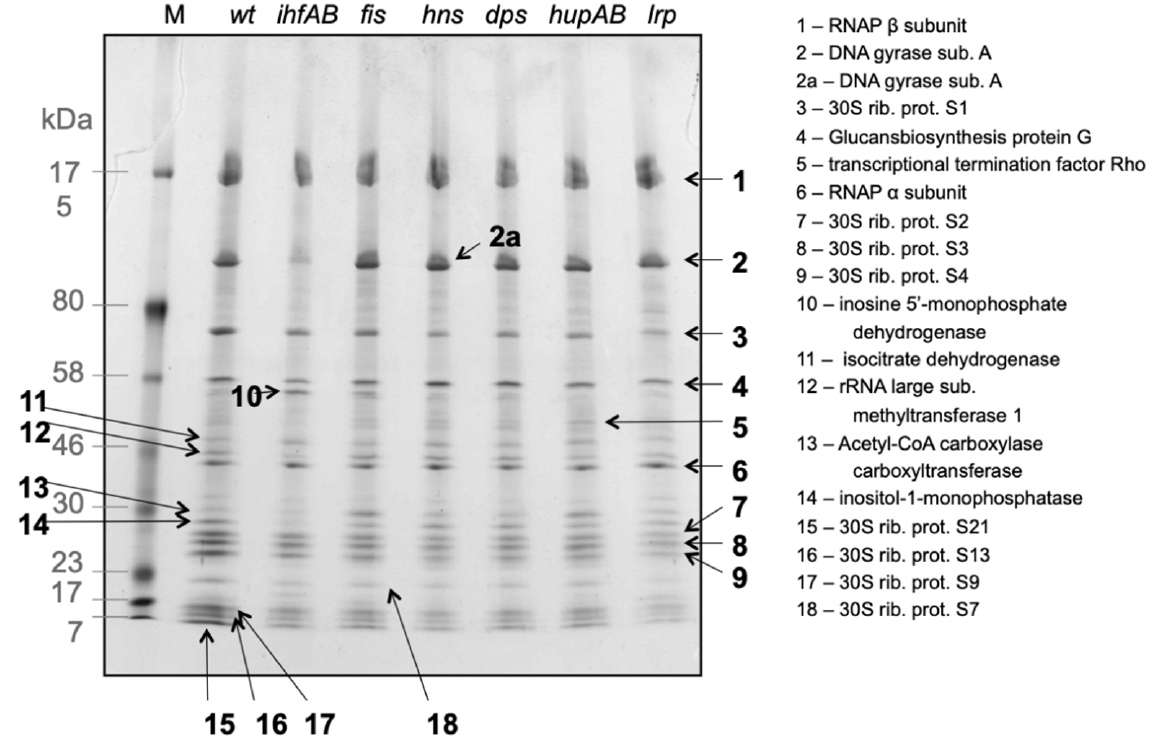
Figure 1. The RNAP supramolecular complex. Coomassie-stained, 2nd dimension SDS-PAGE of RNA polymerase supramolecular complexes isolated from E. coli CSH50 wild type cells and NAP deficient mutants (as indicated above the lines). The shown (2nd dimension) SDS-PAGE was preceded by heparin column chromatography and non-denaturing Blue-Native PAGE, from which the RNAP supramolecular complexes were excised and resolved into individual components by denaturing SDS-PAGE. The bands in the gel were further subjected to in-gel trypsin digestion followed by MS or MS-MS analyses [45]. Protein identities are linked to the numbers. Further details of the protein functions and analyses scores are provided in Supplementary Table S1.